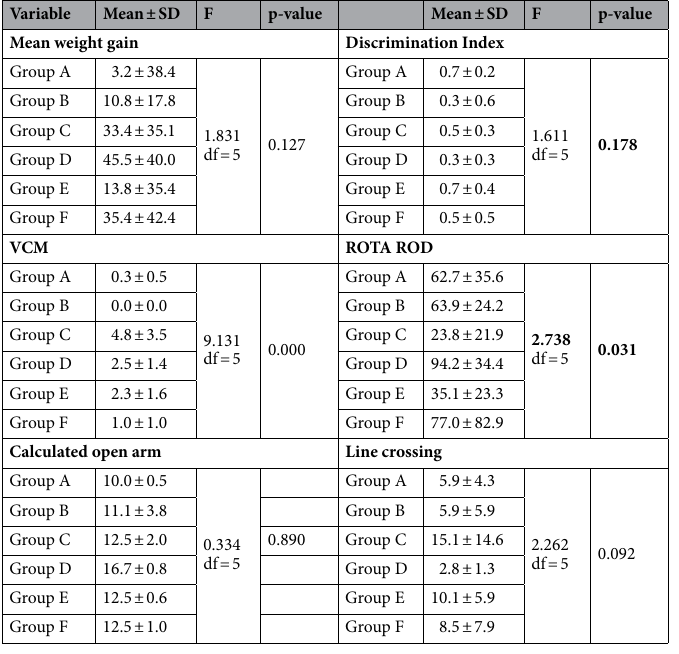
Table 1. Mean weight gain, object recognition, and locomotor activity after the last dose of pharmacological intervention. Significant values are in